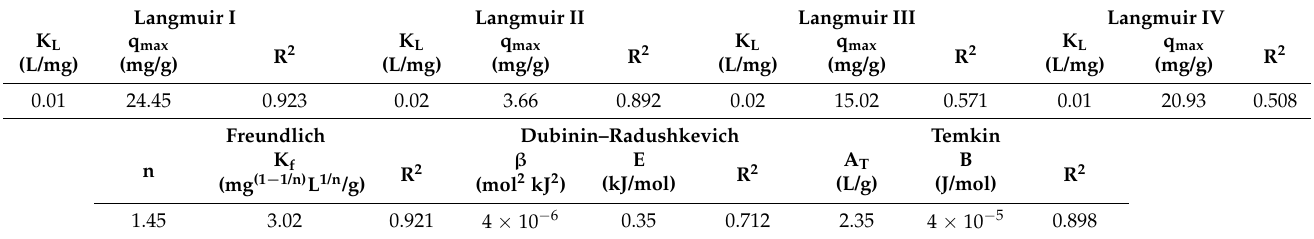
Table 1. Calculated parameters for linearized isotherm models for RR dye adsorption onto